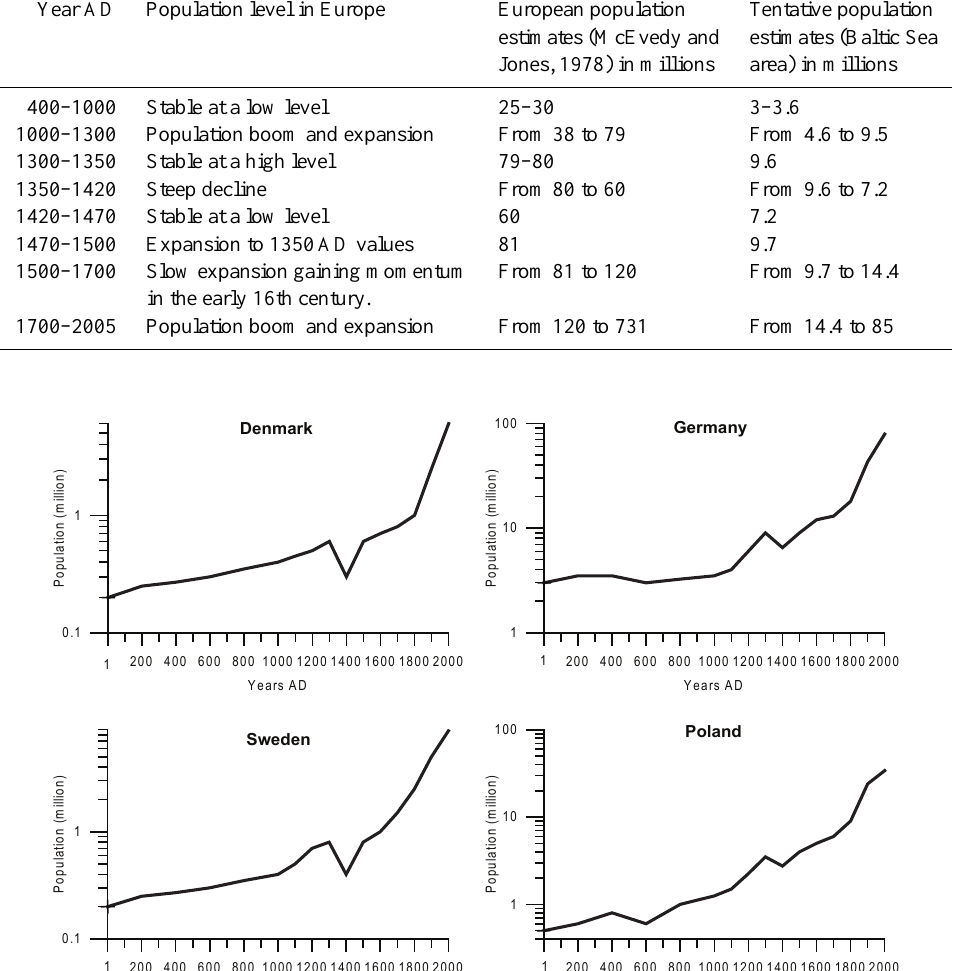
Fig. 3. Estimates of the total population of some the Baltic Sea countries i.e. Denmark, Germany, Sweden and Poland since 1AD (McEvedy and Jones, 1978). Note the rapid increase between 700–1300AD, followed by an equal prompt decrease in the early 14th century, in all of the